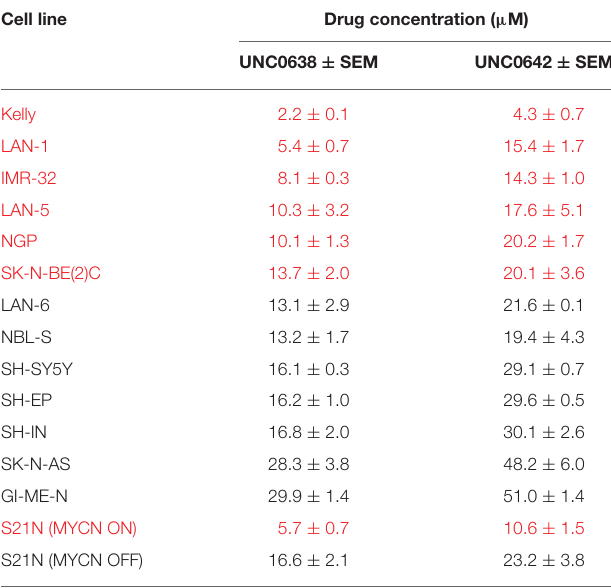
TABLE 1 | IC 50 values of NB cell lines with G9a inhibitors UNC0638 and UNC0642. Cell